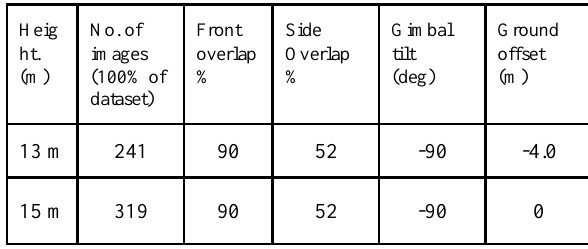
Table 1. Flight settings entered in the Hammer app (™) for